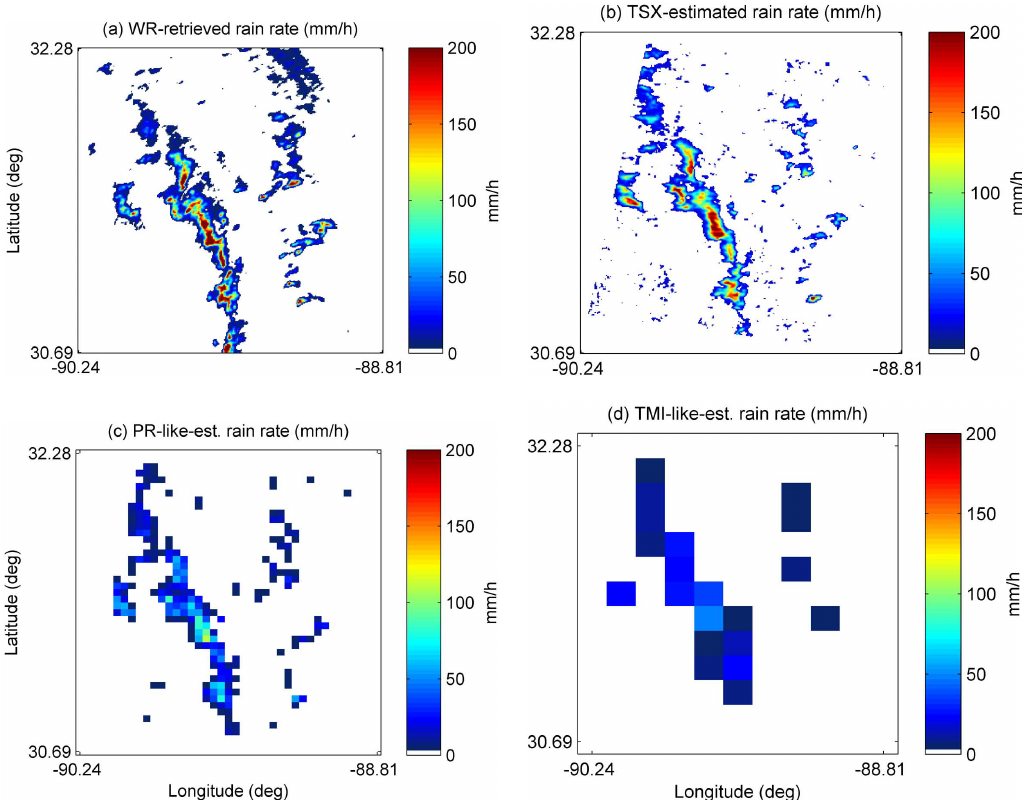
Fig. 7. Top left: map of measured rain rate (mmh − 1 ) obtained by standard NEXRAD Z-R relation of Eq. (5) on the WR reflectivity for the case study in Fig. 1. Top right: map of TSX estimated rain rate (mmh − 1 ) obtained by MREA technique in Eq. (4). Bottom left: map of PR-like estimated rain rate (mmh − 1 ) obtained by Eq. (4). Bottom right: map of TMI-like estimated rain rate (mmh − 1 ) obtained by Eq. (4). PR-like and TMI-like data are obtained by reducing resolution of the TSX data respectively at 4km/pixel and 15km/pixel and applying a Gaussian filter to emulate antenna pattern. TSX and WR input data are obtained from Fig. 4; note that for graphical purposes scales are equally saturated at 200mmh − 1 , even though WR values can be higher than 300mmh − 1